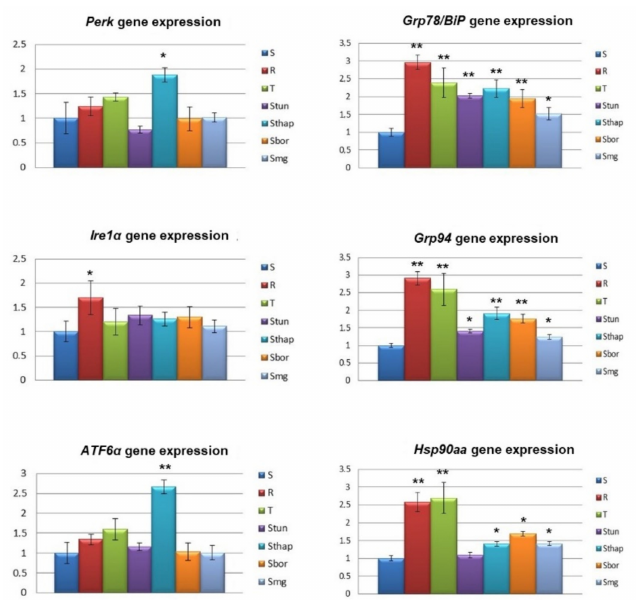
Figure 4. qRT-PCR quantification of protein kinase R (PKR)-like endoplasmic reticulum kinase ( Perk), inositol-requiring enzyme 1 α ( Ire1 α ) , activating transcription factor 6 α ( Atf6 α ) , Grp78 / BiP , Grp94 and Hsp90aa gene expression (using primers listed in Table 2) in S, R, T, S Tun , S Thap , S Bor and S MG-132 cells. Transcript levels were normalized to the β -actin housekeeping gene and are expressed as the mean ± S D of three independent measurements. Significance: Data are higher than those in S cells at * p < 0.02, ** p <